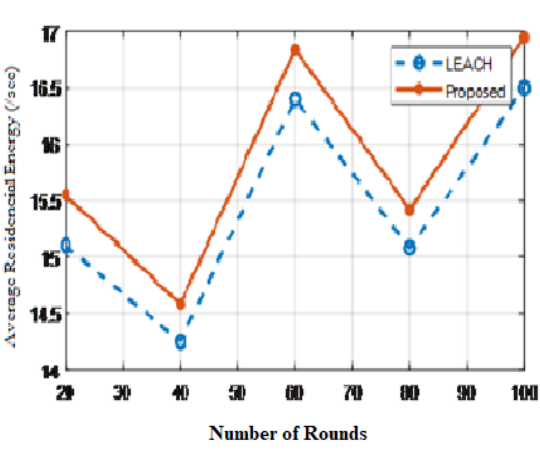
Figure 8. Number of Rounds Vs Average Residual Energy